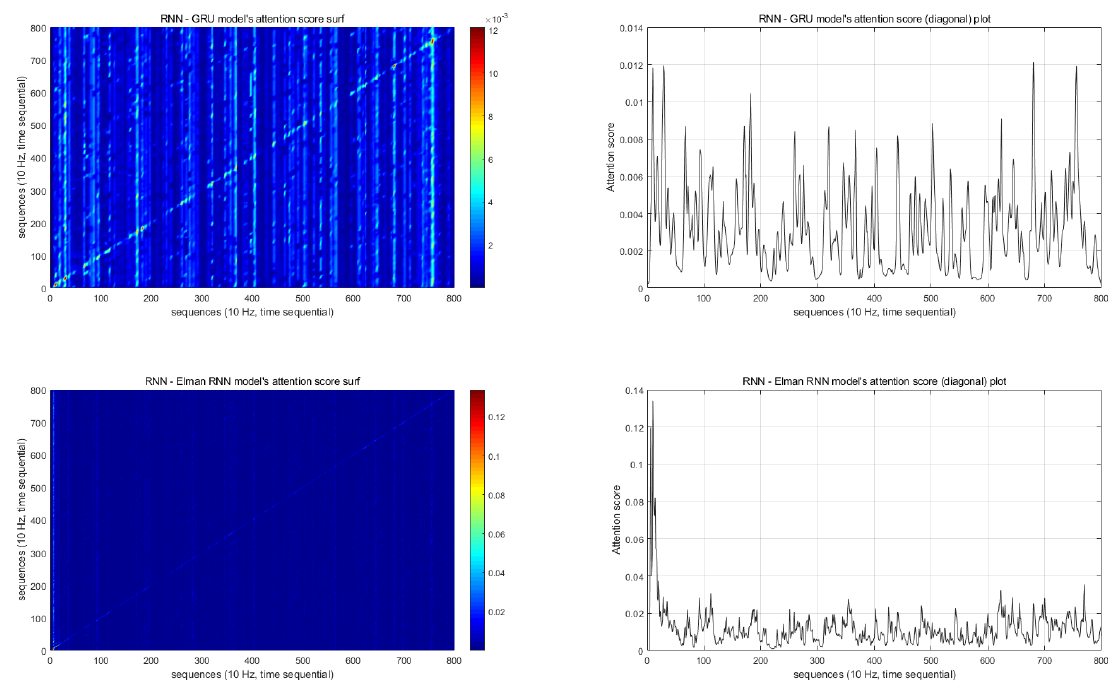
Figure 8. Attention scores. Table 13. LOOCV results for MLP models.